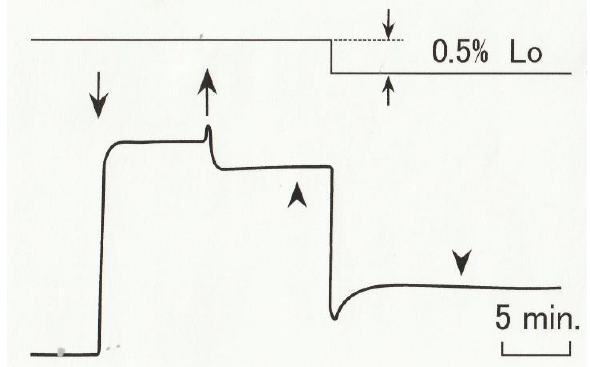
Figure 5. Diagram illustrating the time course of tension changes in high-Ca rigor muscle fibers in response to a ramp-shaped release. The fibers, kept in relaxing solution, are put into contracting solution (pCa, 4), and after full isometric tension was developed transferred to high-Ca rigor solution (pCa, 4). After high-Ca rigor state is established, the fibers were subject to a ramp-shaped release. The time of application of contracting and high-Ca rigor solutions are indicated by arrows, while the fiber length changes are shown above the tension record. Arrowheads indicate times of recording of X-ray diffraction pattern from rigor fibers before and after a ramp-shaped release.